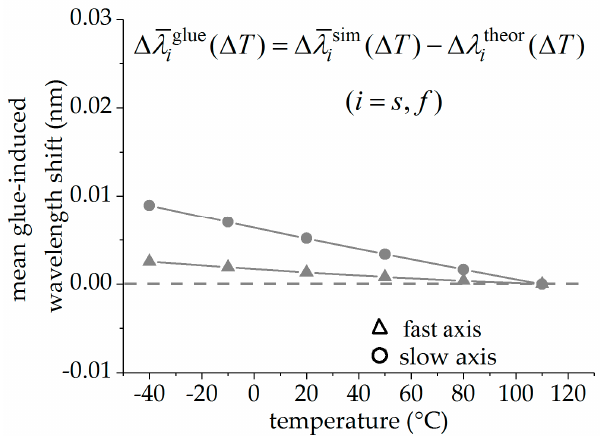
Figure 4. Glue-induced deviations of the mean values of the Bragg wavelength changes to the theoretical transversal stress-free FBG: Triangles mark values of the fast axis and circles of the slow axis.